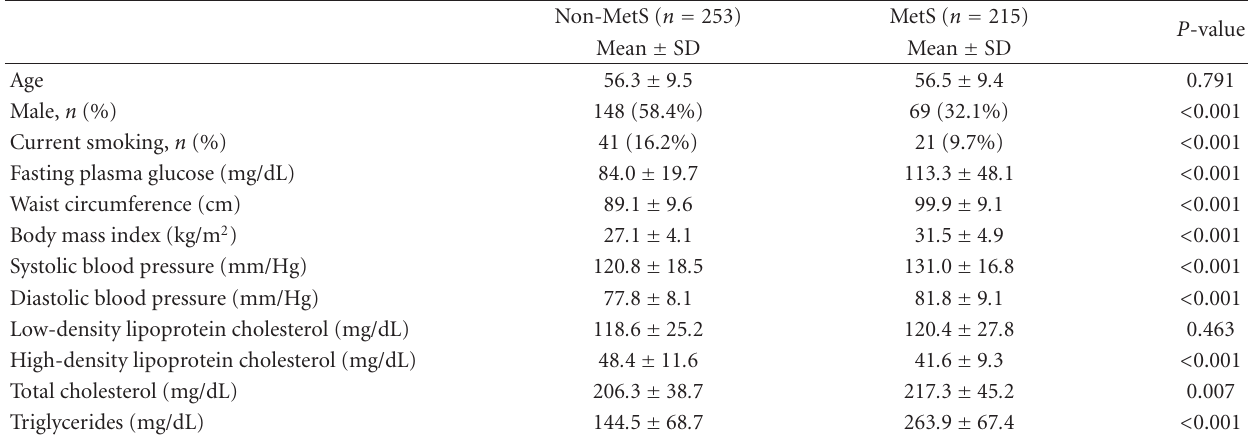
Table 1: Baseline characteristics according to the presence or absence of metabolic syndrome.